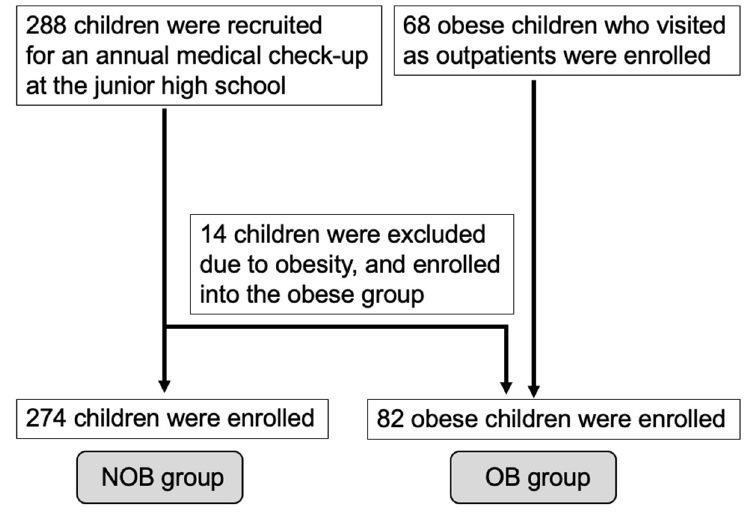
Figure 1. Flowchart showing the process for data selection. Table 1. Clinical characteristics classified based on POW, in the non-obese (NOB) and obese (OB) children groups.